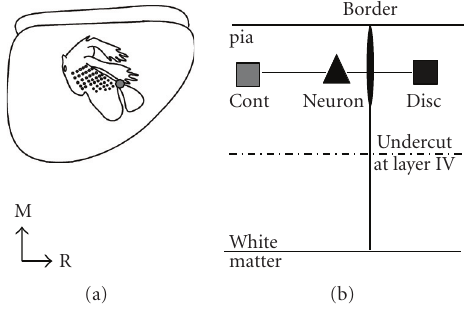
Figure 1: The in vivo and in vitro preparations. (a) Lateral view of the rat brain with a schematic map of S1 overlaid. The gray circle depicts one location of forepaw/lower jaw border. Recordings were made in vivo to determine the location of the border and the border was marked with DiI. (b) Schematic of in vitro slice recording. The top solid line depicts pia and the bottom solid line depicts white matter, the border is the vertical thin line, and the border marked with DiI is the thin oval. The recording electrode recorded from a single neuron (triangle) approximately 100 μ m from the marked border (black oval) and two stimulating electrodes were placed at the same depth from the pia at 300 μ m from the tip of the recording electrode for continuous representation (gray square) and discontinuous representation stimulation (black square). Layer four was undercut (dashed line) in order to isolate the horizontal